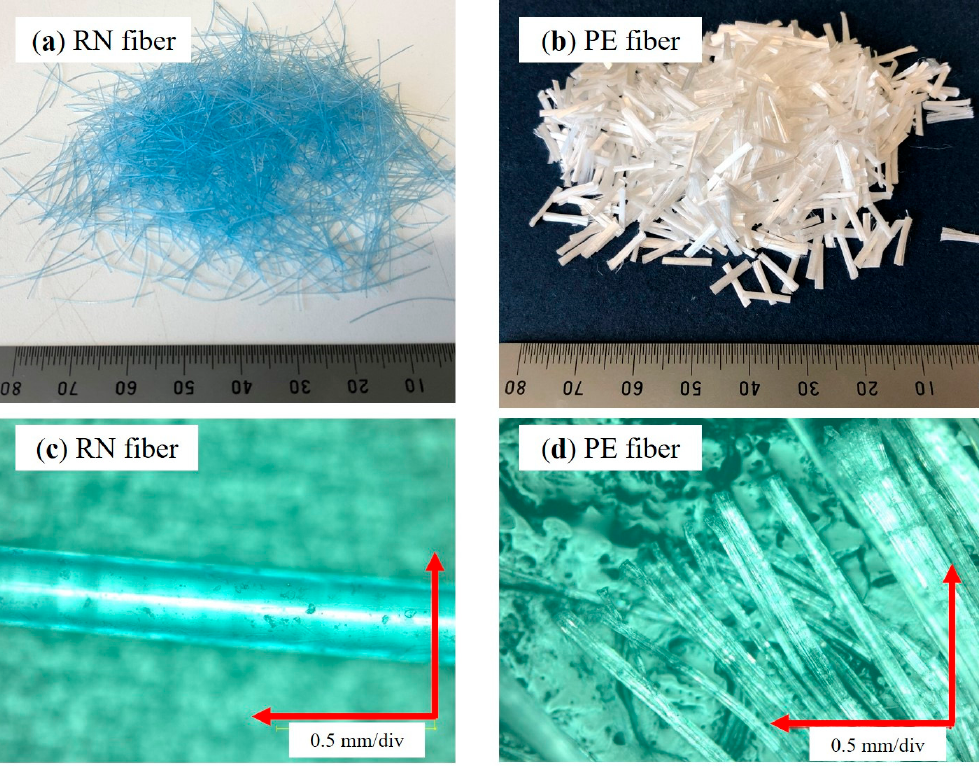
Figure 2. Types of fibers: ( a ) recycled nylon (RN) fiber; ( b ) polyethylene (PE) fiber, and microscope images (×200) of ( c ) RN fiber; ( d ) PE fiber.